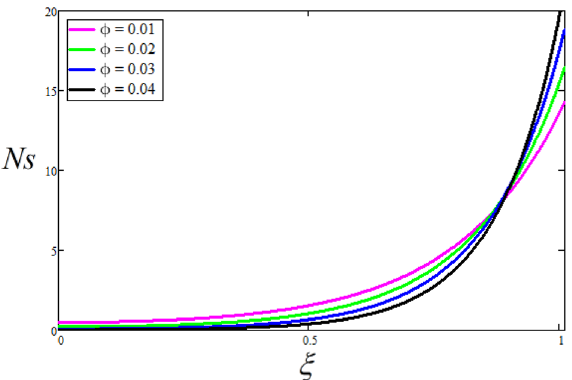
= 2, δ = γ = π , M = 5, k = 0.3, 3